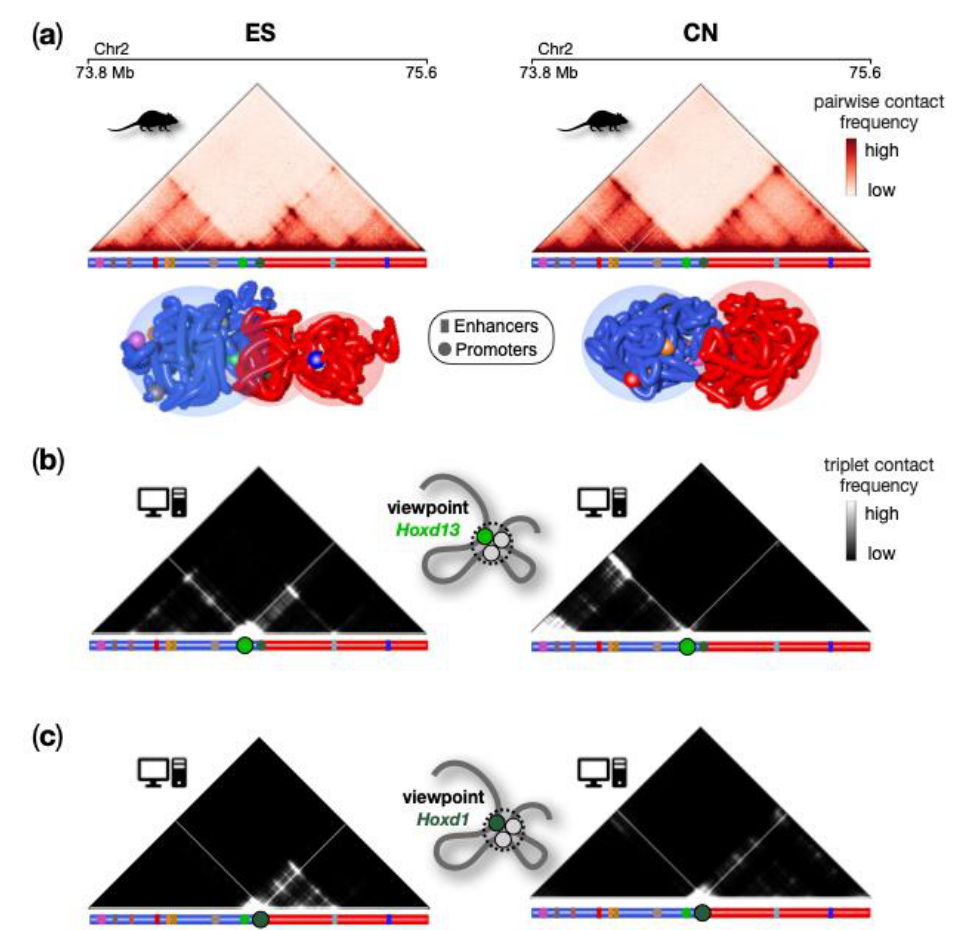
Figure 6. Polymer physics highlights high-multiplicity regulatory contacts at the HoxD locus. ( a ) High-resolution Hi-C data [19] of the HoxD genomic region and model derived single-molecule 3D conformations in ES ( left ) and CN ( right ) cells help visualize the locus structure with its two flanking TADs in the two cell types. ( b , c ) Model predicted triple contact frequency form the viewpoint of HoxD13 ( b ) and HoxD1 ( c ) have a gene and cell-type-specific organization. Image adapted from [39].